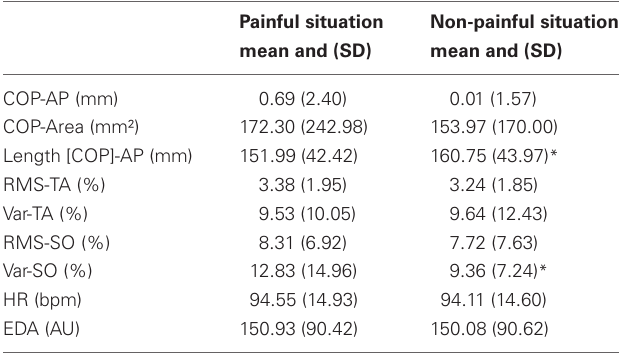
Table 1 | COP displacement and physiological changes as a function of stimuli (painful vs. non-painful).